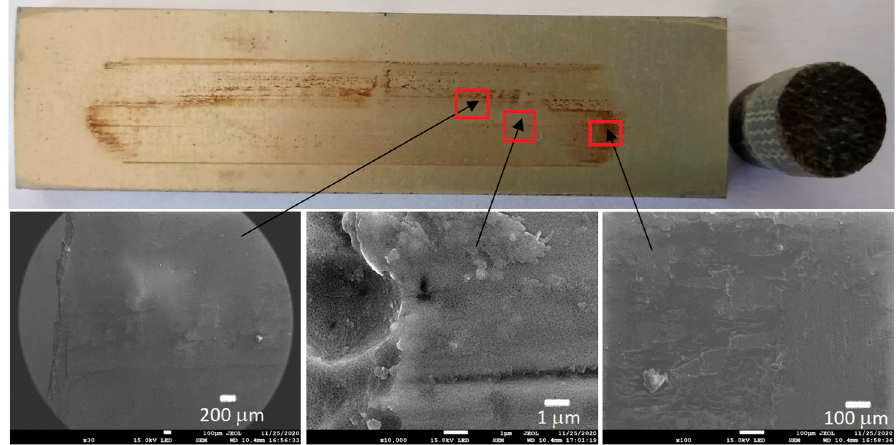
Figure 8. Photographs and SEM micrographs of Al 2 O 3 tribological pairs after a tribological test with PF + cotton + MoS 2 .